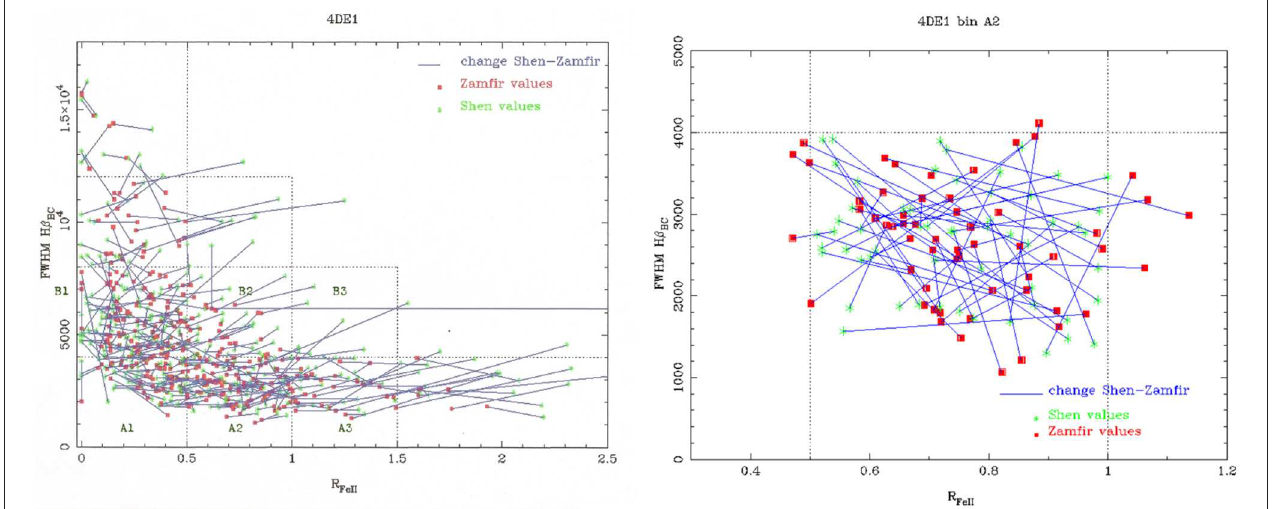
FIGURE 3 | Left: a comparison between Shen et al. (2011) and Zamfir et al. (2010) in the optical plane of 4DE1 involving the FWHM of H β in km s − 1 and the strength of optical Fe II ( R FeII parameter). The blue lines connect Zamfir et al. (2010) (green stars) with Shen et al. (2011) measurements for the same objects. Right: A2 and part of adjacent bins in the 4DE1 optical